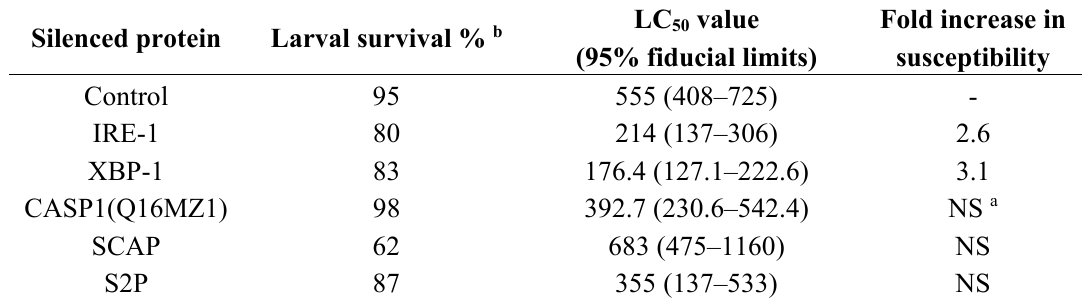
Table 1. Percentage of larval survival up to 4th instar after silencing and toxicity of spore-crystal suspensions of Cry11Aa against Aedes aegypti